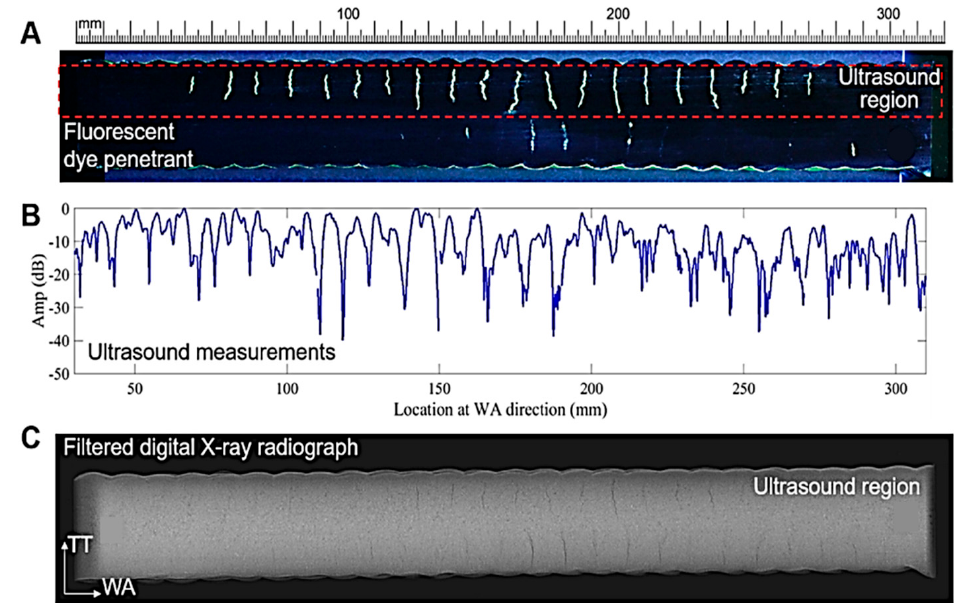
Figure 2. A comparison between dye penetrant testing (the dashed section in ( A ) depicts the area examined with ultrasound techniques shown in ( B )) ( A ), conventional ultrasonic ( B ) and X-ray radiographic technologies ( C ) carried out by Seow et al. [20].